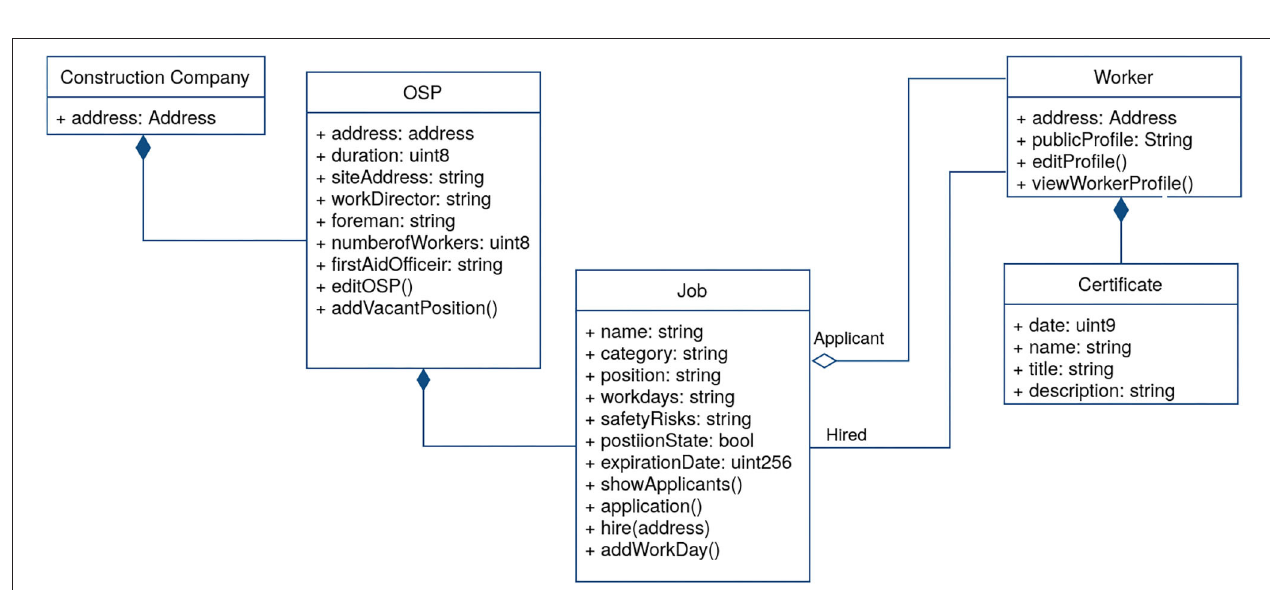
FIGURE 5 | The high-level block diagram for the design of the interfaces of the on-chain component.